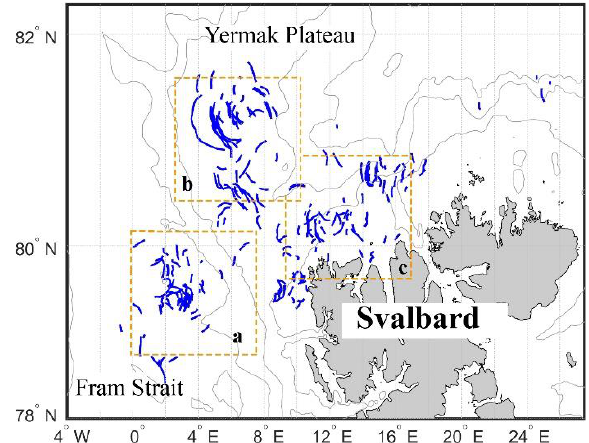
Figure 3 . Spatial distribution of leading waves of SIW trains detected in sequential Sentinel-1 A/B images over the study region in June-September 2018.